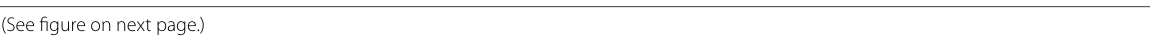
0.0108, ** P 0.001, **** P < 0.0001. GEPIA2 gene expression = =